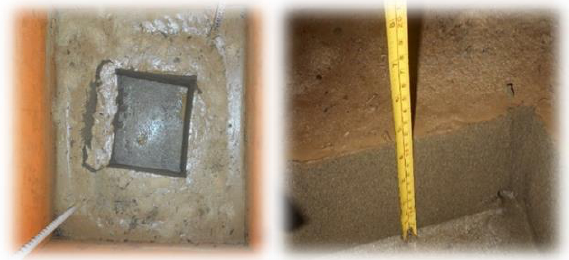
Fig. 5. Penetration of structure inside the ground after the application of dynamic loading